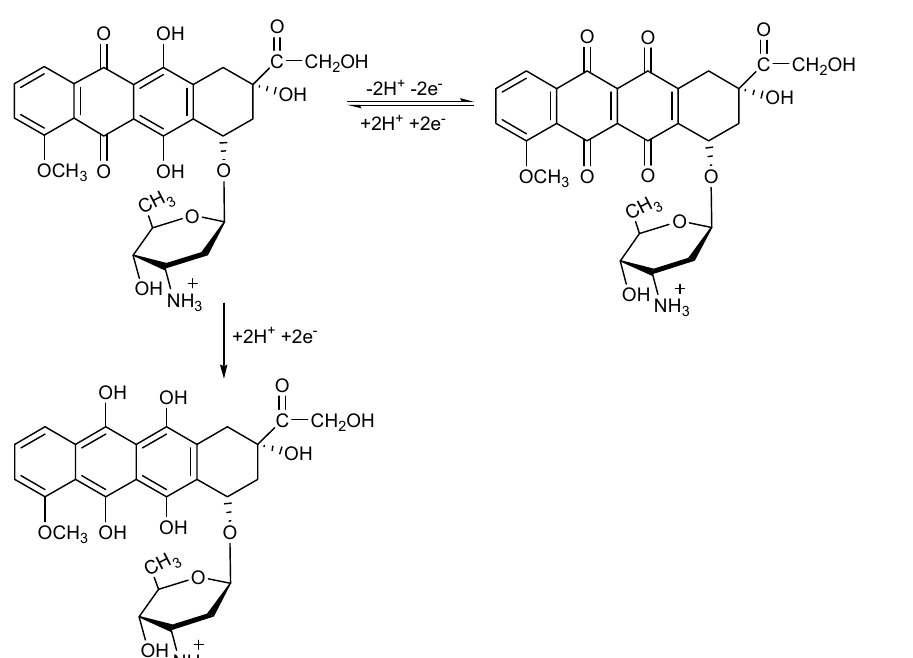
( c ) Figure 7. ( a ) Cyclic voltammograms recorded in 5 mgL − 1 DOX and 0.1 M Na 2 SO 4 supporting electrolyte with the GRQD/CNT paste electrode at various scan rates: (curve 1) 10, (curve 2) 20, (curve 3) 30, (curve 4) 40, (curve 5) 50, (curve 6) 60, (curve 7) 80, (curve 8) 100, and (curve 9) 200 mV·s − 1 .; ( b ) Dependence of peak potential vs. logarithm of the scan rate. ( c ) Dependence of anodic peak current vs. square root of the scan rate.